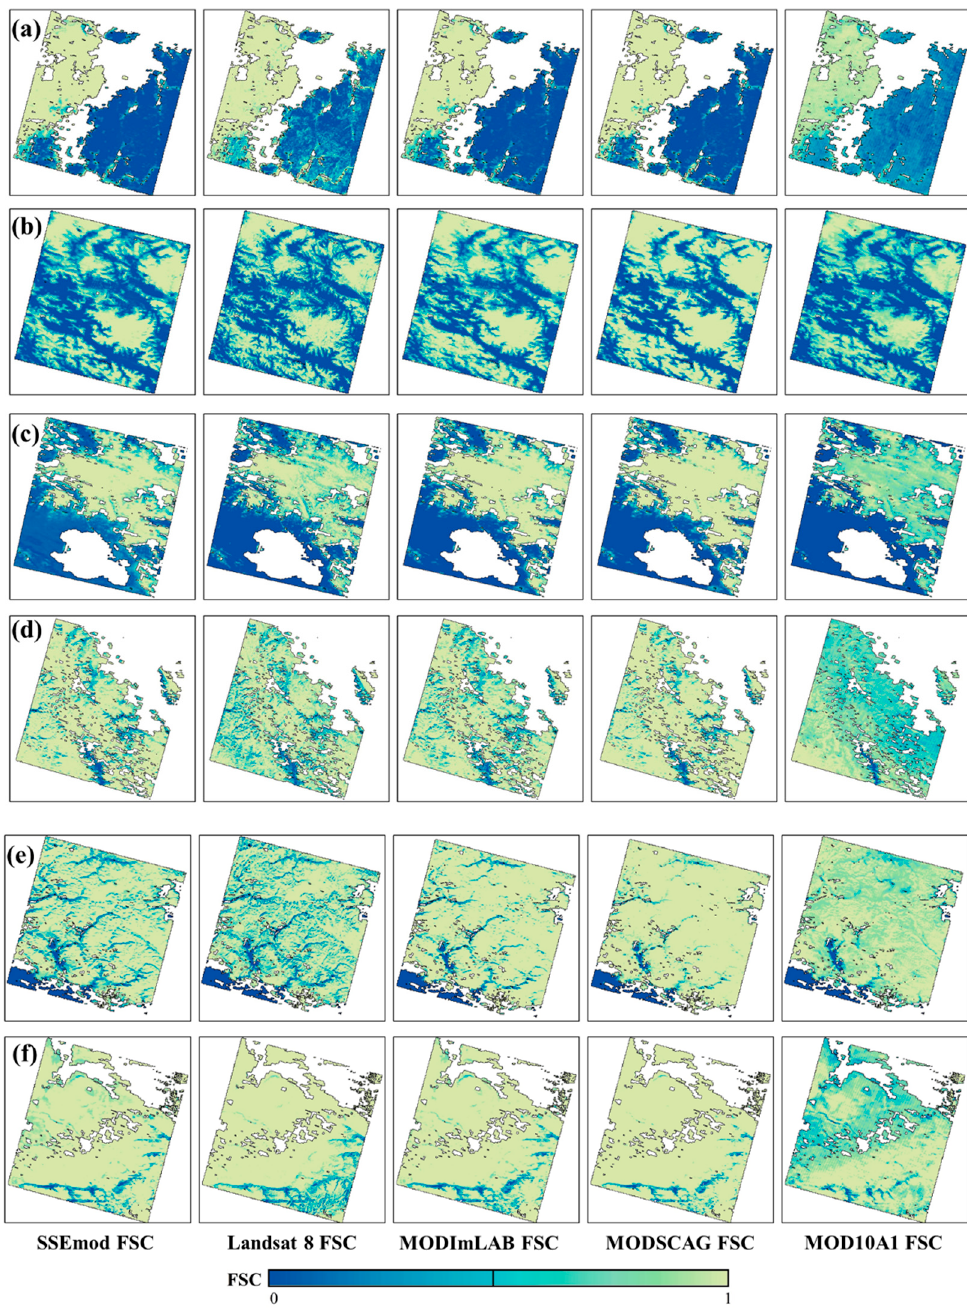
Figure 9. The result of SSEmod FSC, Landsat 8 FSC, MODImLAB FSC, MODSCAG FSC, and MOD10A1 FSC in di ff erent snow cover regions of China. ( a – f ) donates diverse validation images in the three main snow cover areas of China.